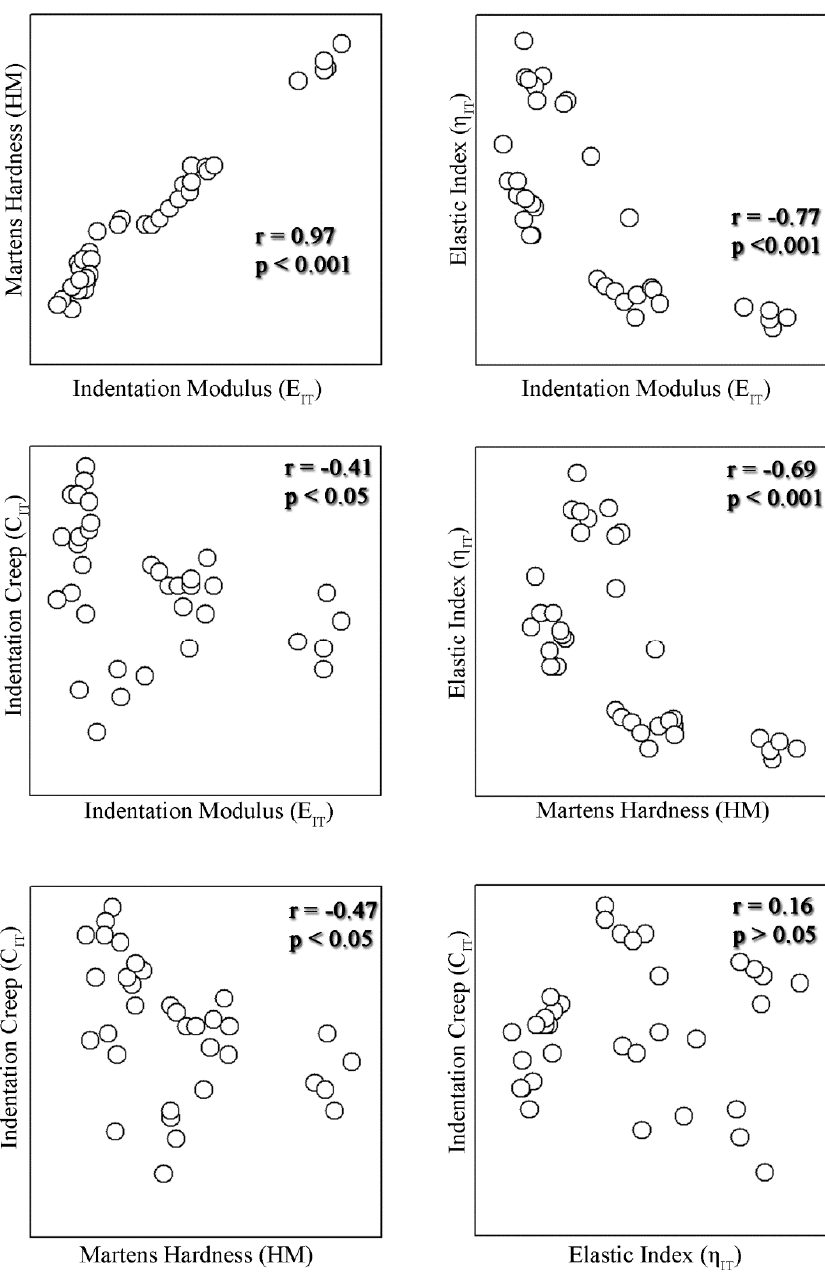
Figure 4. Spearman correlations between the four properties tested. All pairs showed positive or negative correlations apart from the indentation creep with elastic index.